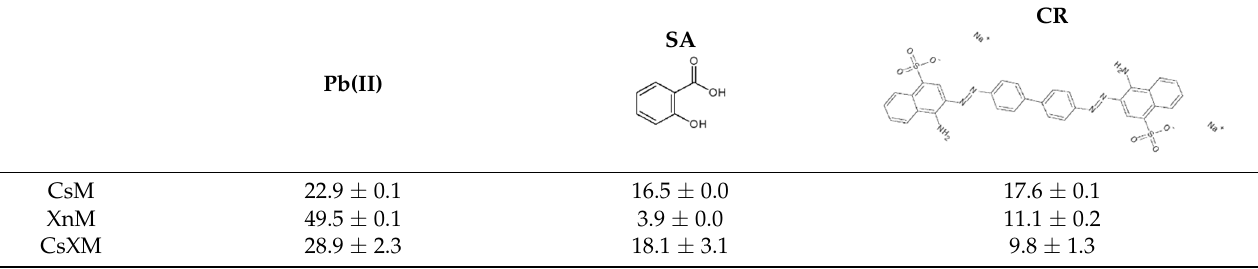
Table 2. Percent removal of Pb(II), SA, and CR by CsM, XnM, and CsXM. Chemical structures of SA and CR are given in the table.